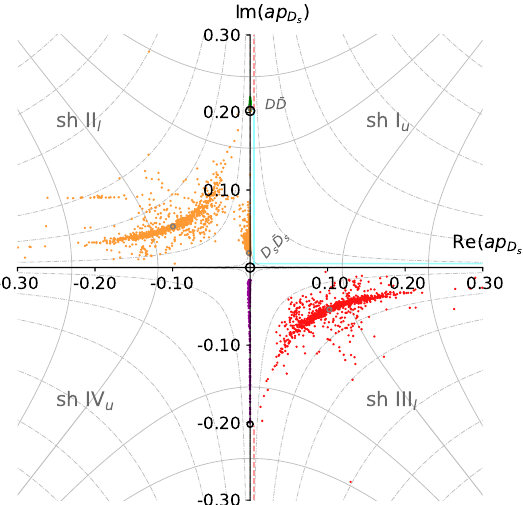
Figure 14 . Pole distribution of different poles, presented in figure 6, across various bootstrap samples in the complex p D plane where p D is the momentum of the D s meson in D s ¯ D s scattering s s in the CMF. The color coding of the poles are the same as in figure 6. The pole positions for the ensemble average of the data are shown with gray unfilled circles. The gray solid (dot-dashed) curves represent the lines of constant real (imaginary) aE cm . The cyan line represents the physical axis presented in figure 1. The red dashed lines indicate the region below the elastic threshold, where the sheets are not